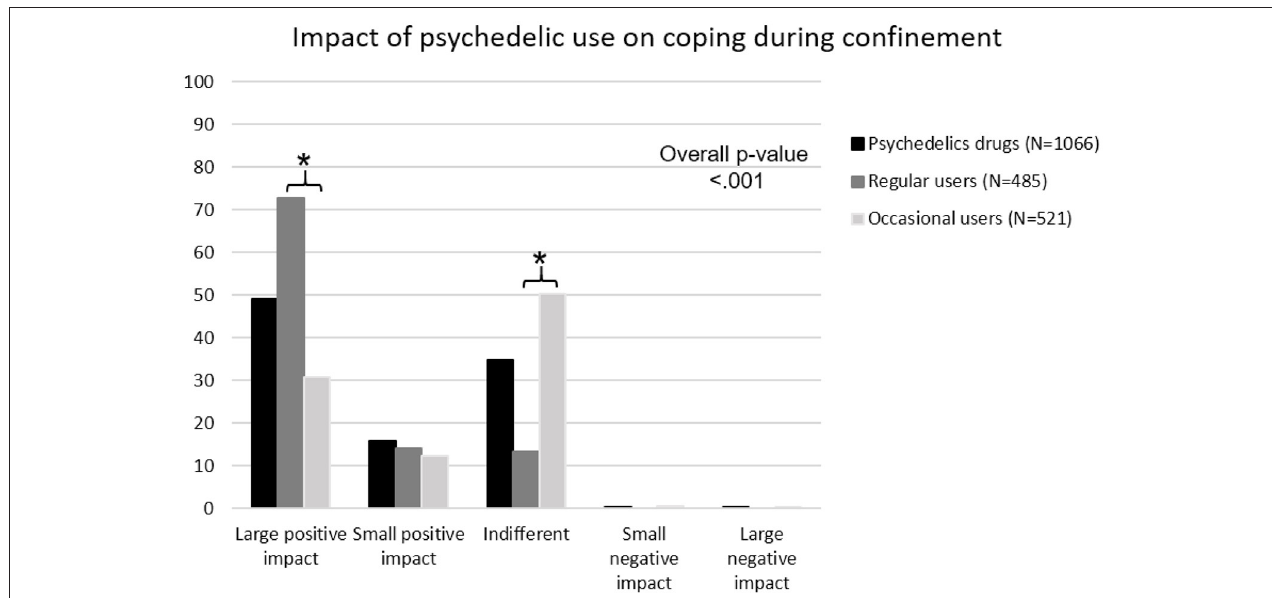
FIGURE 1 | Self-rated impact of psychedelic drug use on managing the COVID-19 confinement period. Black bar refers to persons that have never taken psychedelic drugs; dark gray bar refers to the regular users; and light gray bar refers to occasional users. Overall p -value is calculated with Chi square test, and * mark significances between regular and occasional users with p <